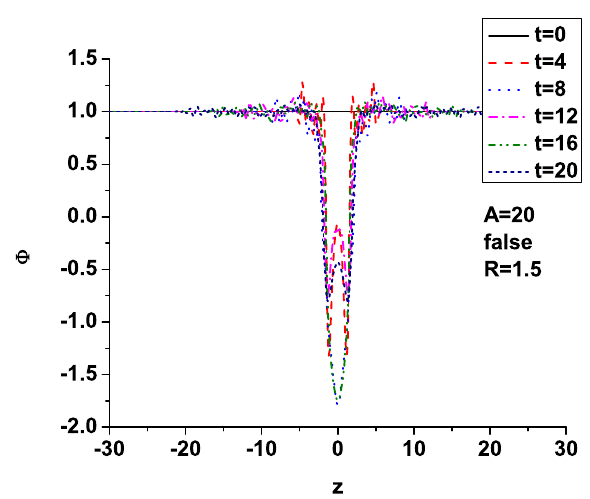
Figure 9 . A massive object affecting the vacuum in its neighborhood. We set initial v O = 0 , A = 20 , R = 1 . 5 , Λ = 1 , B = 1 , m = 10 10 , a = 0 . 2 , r = 0 . The whole space was initially occupied by φ = Λ .